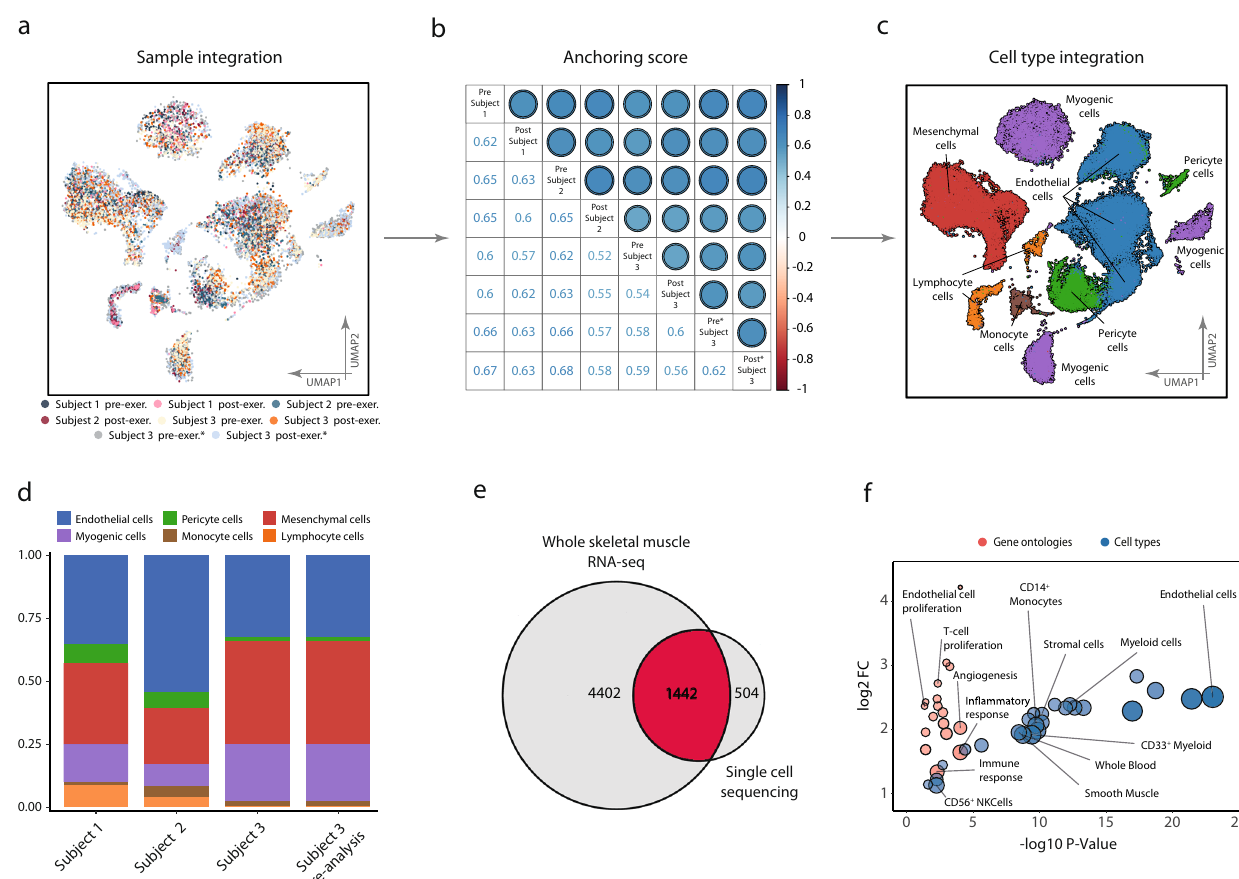
Fig. 1 Data alignment and reproducibility. Reproducibility of scRNA-seq between and within subjects. a A total of 63 000 cells isolated from six vastus lateralis muscle biopsies from three different subjects were processed, clustered, and visualized using UMAP projection, with color coding indicating the contributing donor and sample. Cells aligned into six major cell populations in which cells from all donors were evenly distributed, providing a measure of reproducibility of cellular composition. b This was further con fi rmed by consistent anchoring scores, a measure of correlation between samples, both within and between subjects, as shown in the correlation-matrix. c Cell-type annotation identi fi ed six different cell types/lineages as indicated on the UMAP. d Cell-type composition in all subjects at baseline, including resequencing of one subject to con fi rm reproducibility within and between samples. Endothelial cells were the most abundant cell type constituting 44% of the samples followed by mesenchymal 26% and myogenic cells at 18%. Complete composition can be found in Supplementary Data 1. e Based on the sequencing data from homogenized whole tissue, 5844 transcripts were identi fi ed as part of the skeletal muscle transcriptome and 1946 unique transcripts were detected with the scRNA-seq. A substantial proportion (504 or 26%) of these transcripts were detected only with the scRNA-seq. f The unique transcripts from scRNA-seq analysis were highly enriched in genes from endothelial, immune, and stem cell populations, suggesting that scRNA-seq captures a transcriptional signature of cell populations that otherwise goes largely undetected when using